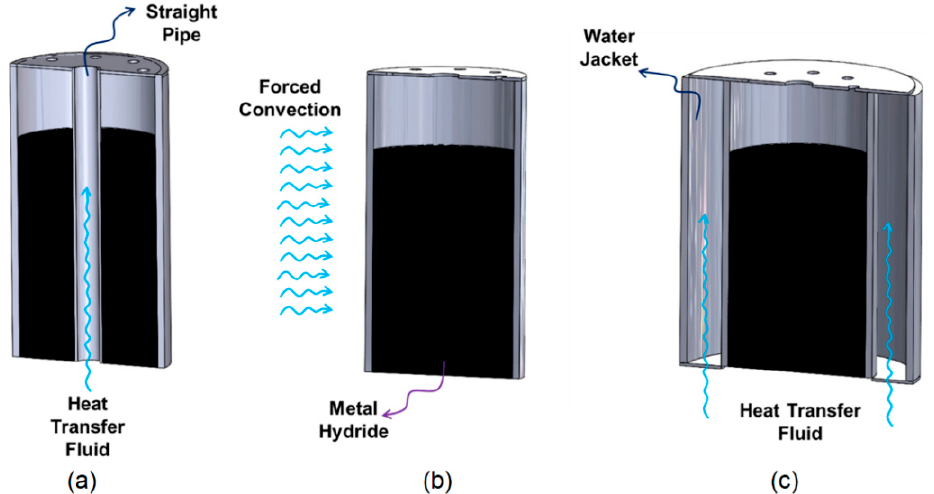
Figure 5. Active thermal management with ( a ) using straight pipe, ( b ) using forced convection, and ( c ) using a water jacket (Reproduced with permission from Ref. [20]. 2022, Elsevier.).